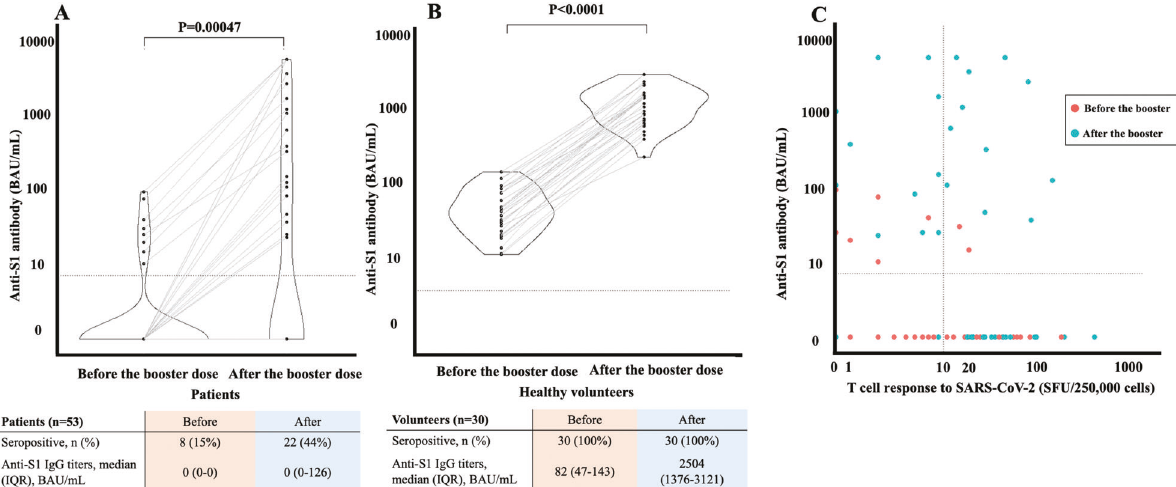
Fig. 1 Anti-S1 antibody titers before and after booster vaccination. Booster vaccination in A patients and B healthy volunteers. P indicates probability value. P value was calculated via Wilcoxon signed-rank test. C Dot plot showing the humoral and cellular responses before and after booster vaccination in patients. Orange and blue dots indicate patients before and after the booster vaccination, respectively. Horizontal dot lines indicate 7.1 BAU/mL, and vertical dot lines indicate 10 SFUs per 250,000 cells and cutoff values of serological and cellular responses,